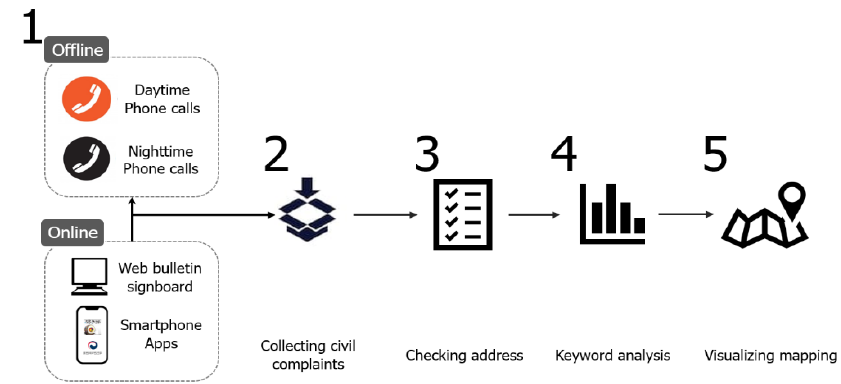
Figure 3. Flowchart of our F igure 3. Flowchart of our research.